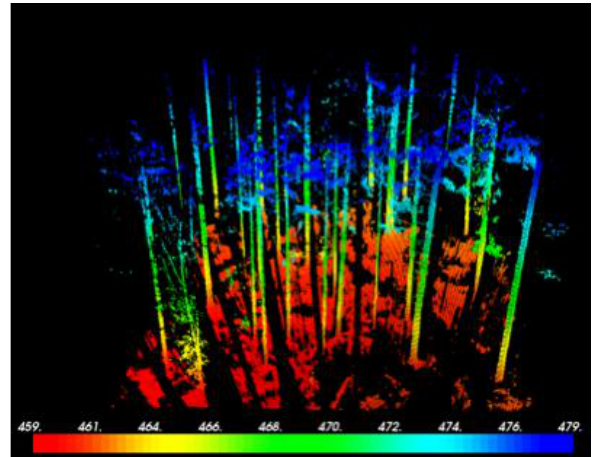
Figure 2. single scan study area “Bremgarten”, colors in m a.s.l